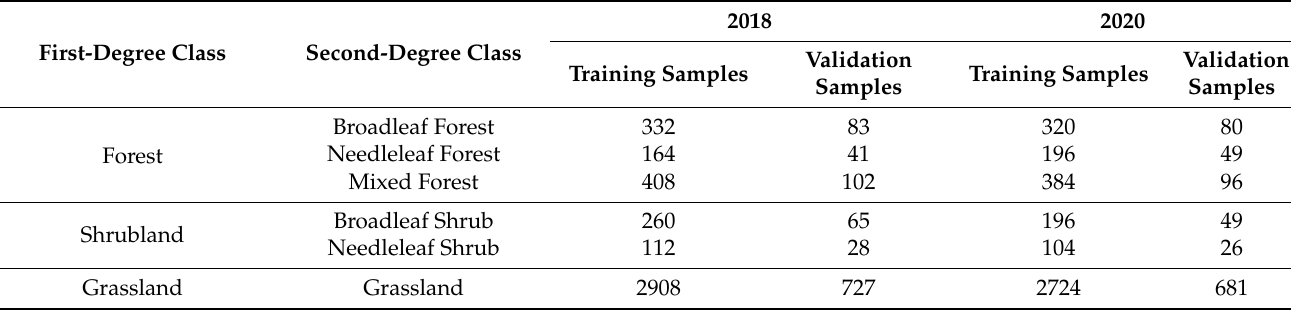
Figure 2. Spatial distribution of LULC first-degree class sample points. ( a – h ) Sentinel-2 RGB true- color composite image of LULC first-degree class sample points and aerial photographs of the field. Table 1. Training and validation sample points in this study.